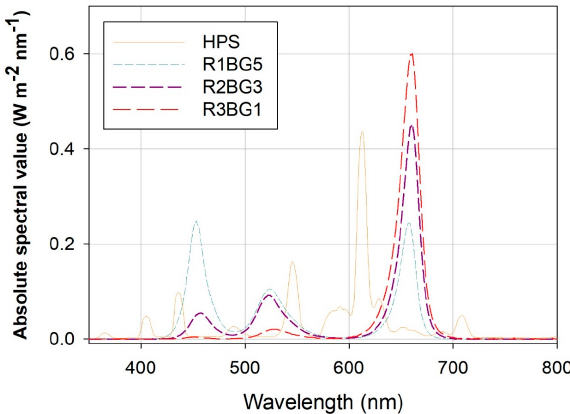
Figure 2. Spectral distribution of lights (350–800 nm) under the four light treatments, measured using a portable optical meter (EverFine PLA-20, Yuanfang Elect. S&T Inc., Hangzhou, China). HPS—high-pressure sodium lamps; R1BG5—electric current for red and combined green and blue LEDs were controlled to be 10% and 50%, respectively; R2BG3—electric current was controlled to be 20% (red) and 30% (green and blue); R3BG1—electric current was controlled to be 30% (red) and 10% (green and